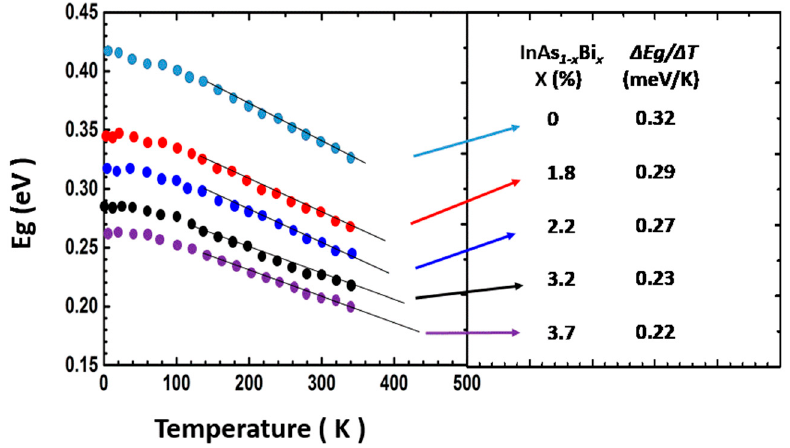
Figure 14. Temperature dependence of the bandgap of various InAsBi layers. Reproduced from Reference